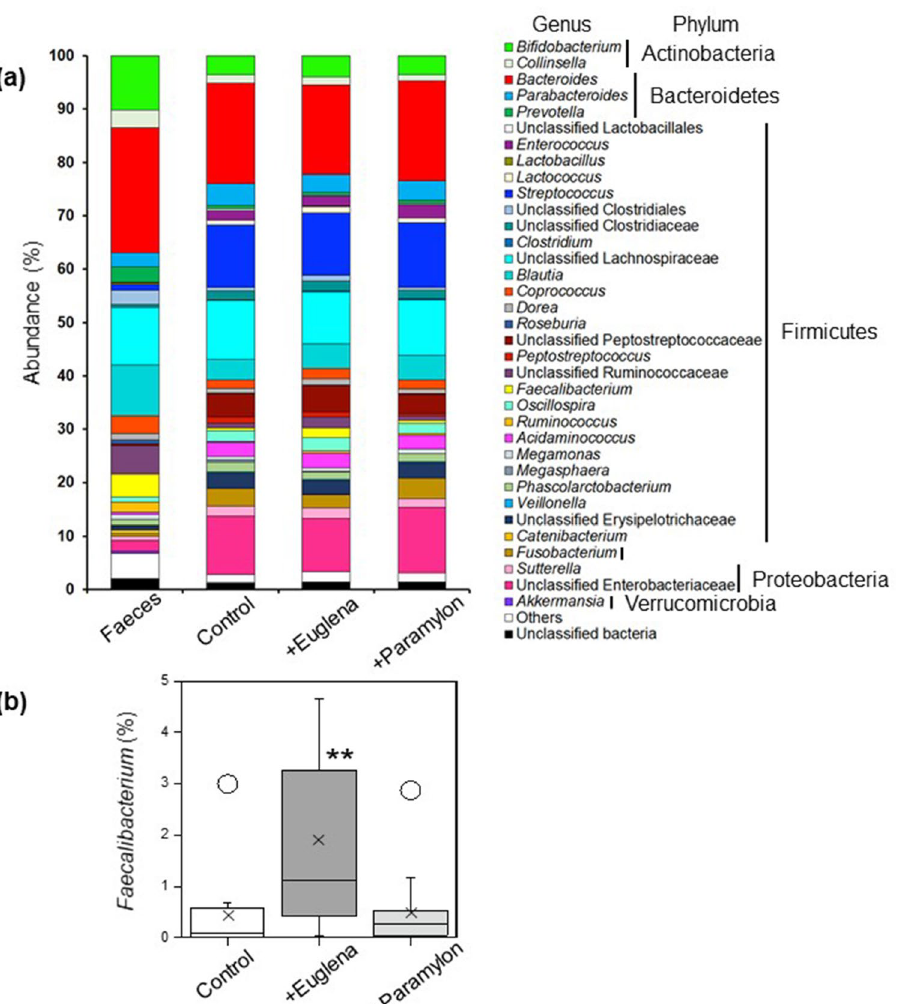
Figure 1. Euglena gracilis addition changes microbiota composition. ( a ) Genus-level compositional view of bacteria in the original faecal samples (Faeces), in vitro human colonic microbiota models (Control), models with E. gracilis (+ Euglena), and models with paramylon (+ Paramylon) after 48 h of fermentation. The means of 11 samples from healthy human subjects are shown. Genera of lower abundance (< 1.0%) and lower similarity (< 97%) were included in Others and Unclassified Bacteria, respectively. ( b ) Box-and-whisker plots representing relative abundances of bacteria related to Faecalibacterium . ** P < 0.01, n = 11, Wilcoxon signed rank test. Circles outside the whiskers represent outlier